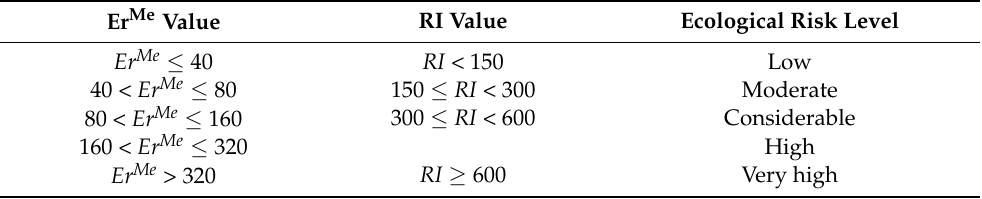
Table 4. Values of the RI